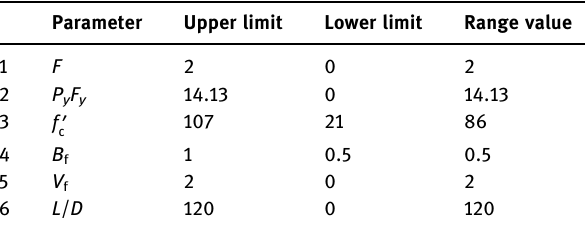
Table 4: Upper and lower limits of input parameters of this study Parameter